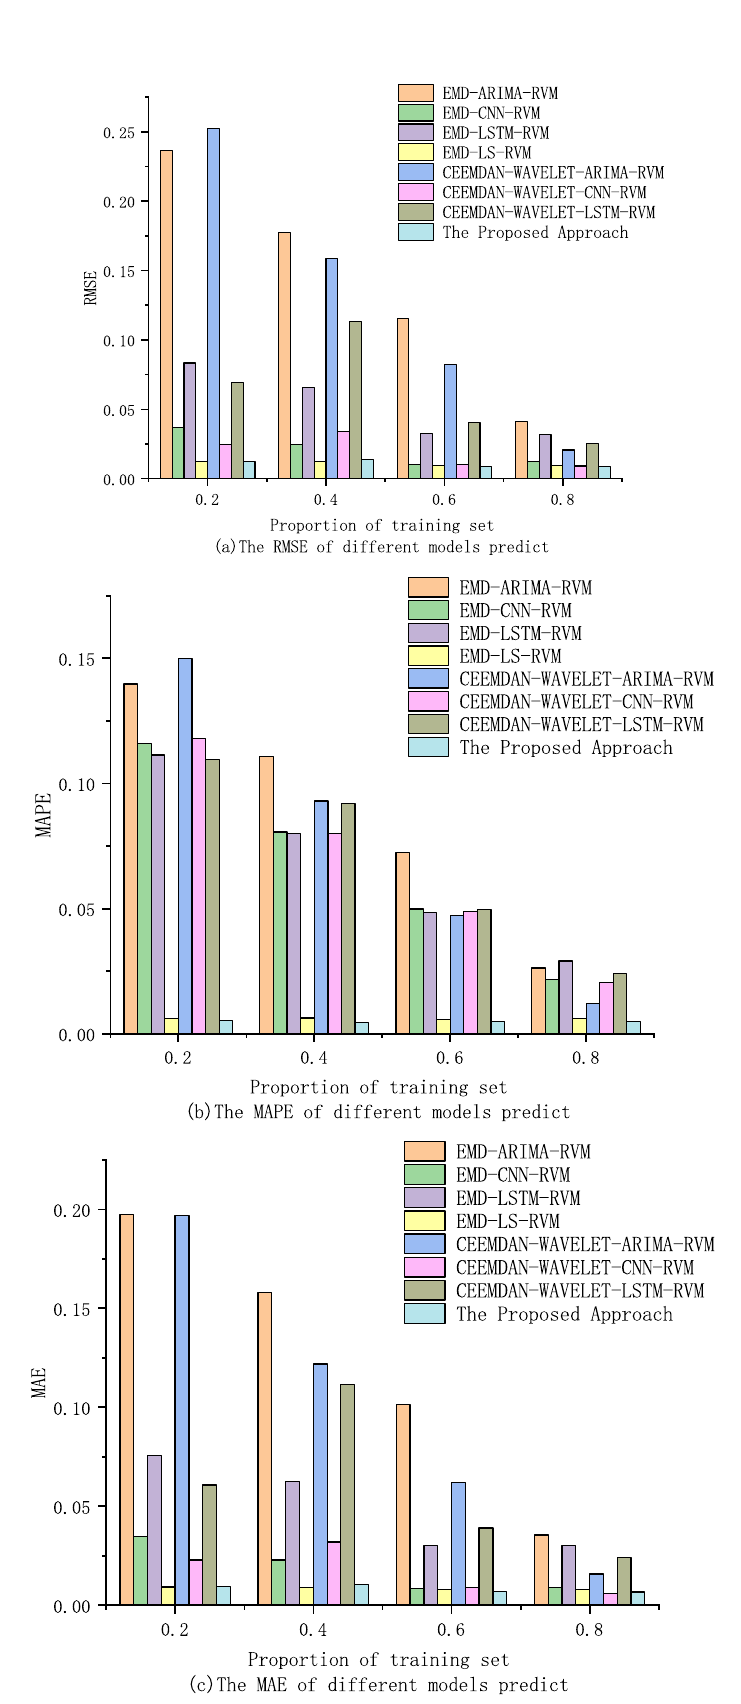
Figure 10. Comparison of index errors of each